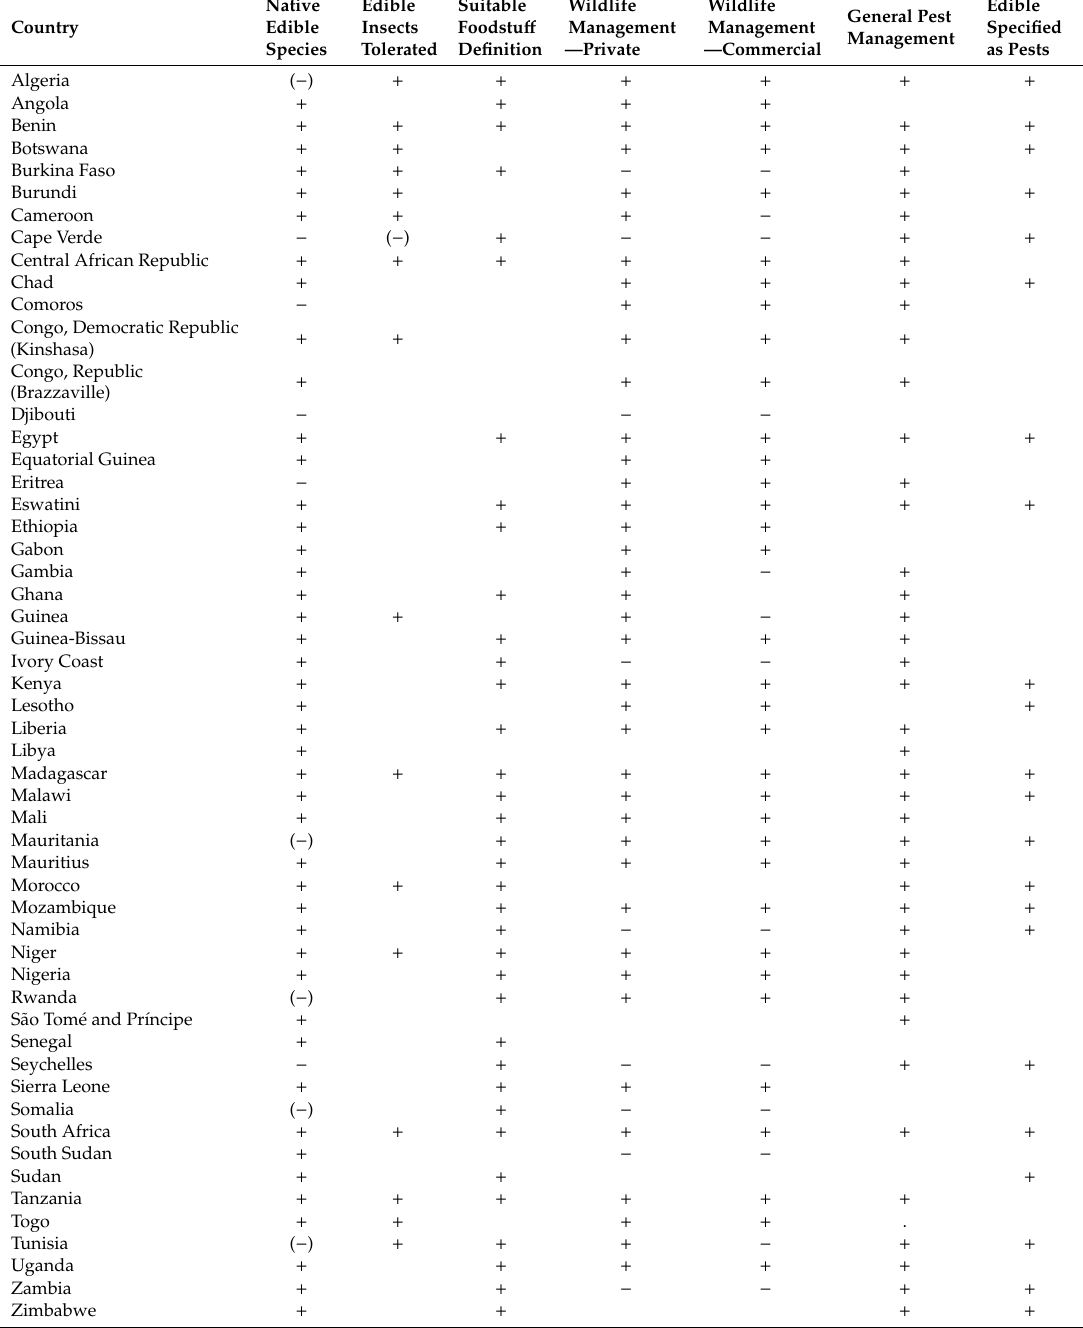
Table 11. Summary of the legal context of edible insects in